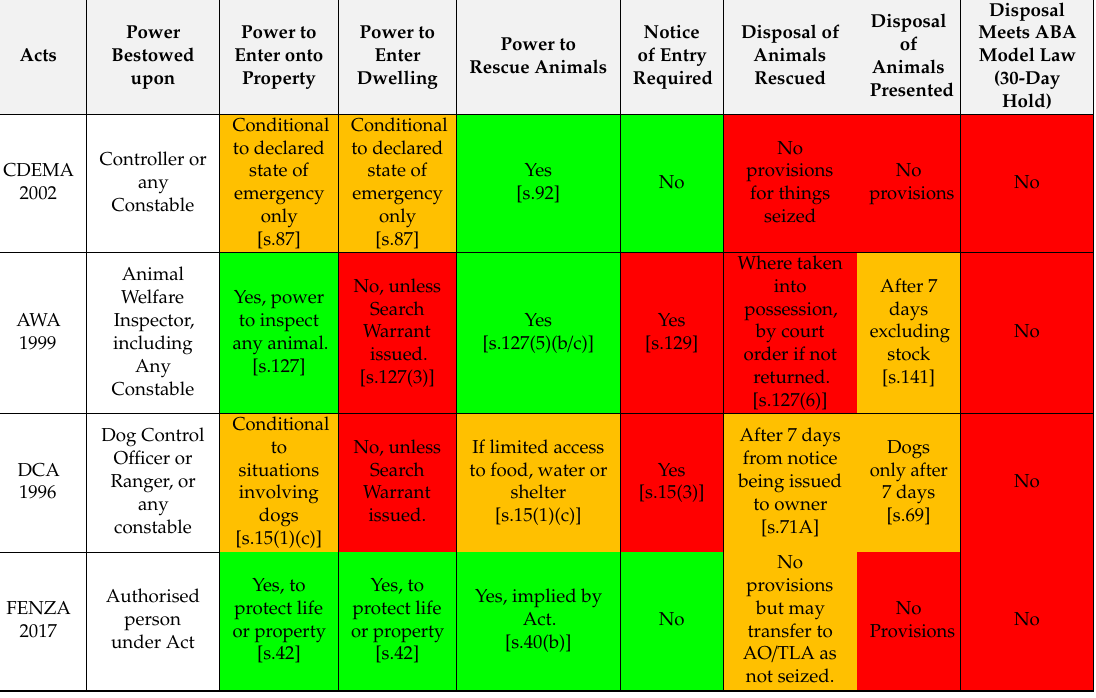
Table 1. Legal phases of animal disaster rescue (revised)